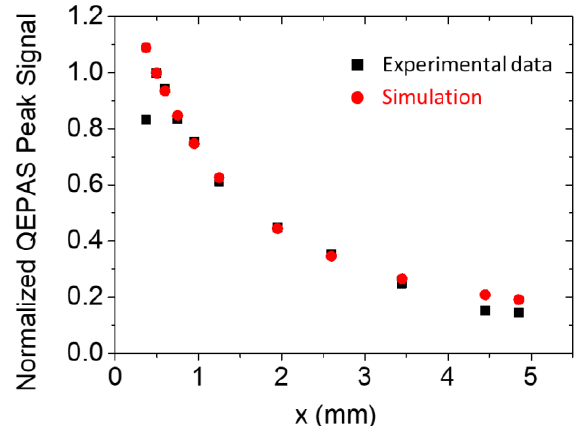
Figure 4. Normalized QEPAS Peak signal as a function of the distance between the two tubes ( ■ ),